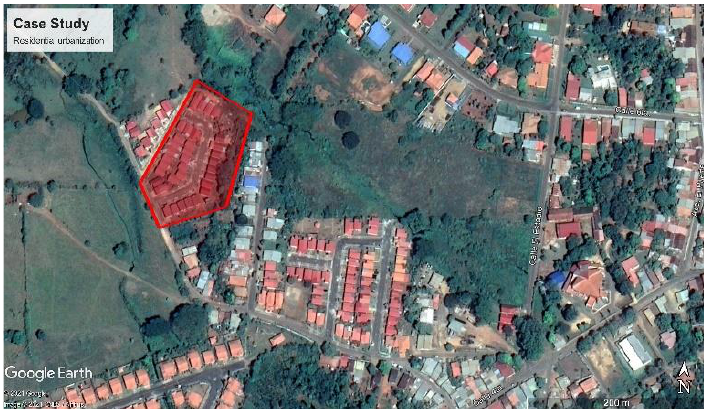
Figure 3. Methodology used for the research. Own elaboration.